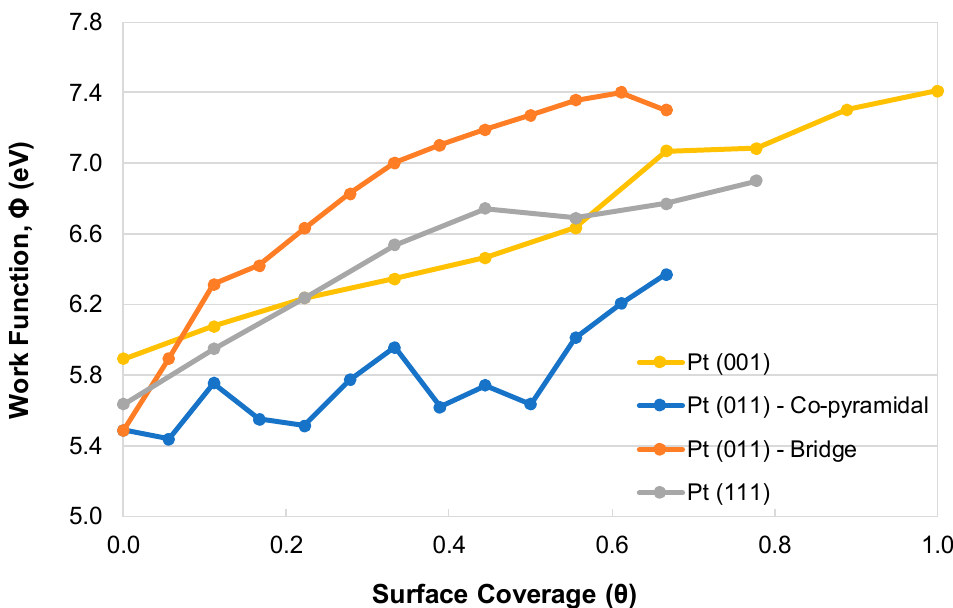
Figure 6. E ff ect of increased SO 2 concentration on the work function of the Pt (001), (011), and (111) surfaces.